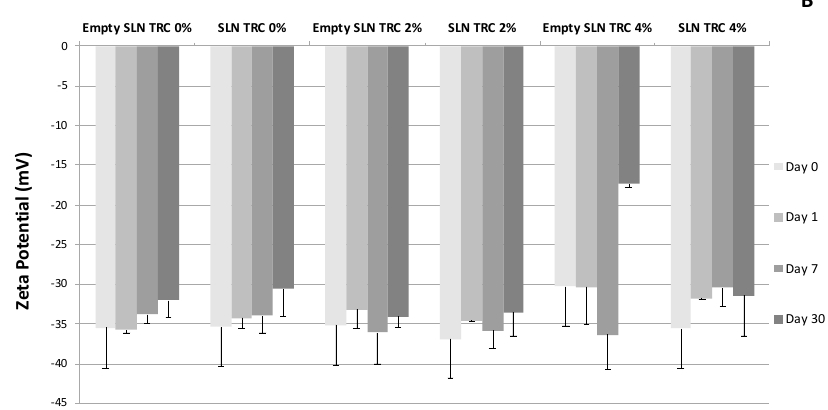
Figure 2. Values of mean diameter, polydispersity index ( A ), and zeta potential ( B ) of 8-MOP-loaded and -unloaded SLNs collected over 30 days of storage at 25 ± 1 °C. Mean values ± standard deviation (error bars) were reported from at least 3 independent samples.